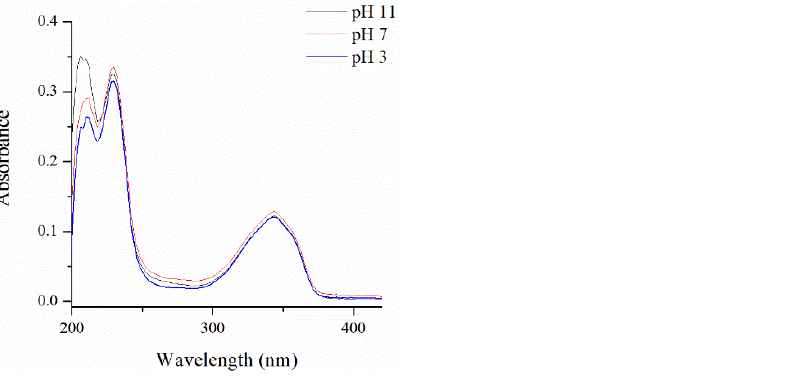
Figure 1. Absorption spectra of probe 4 in aqueous solution at different pHs.